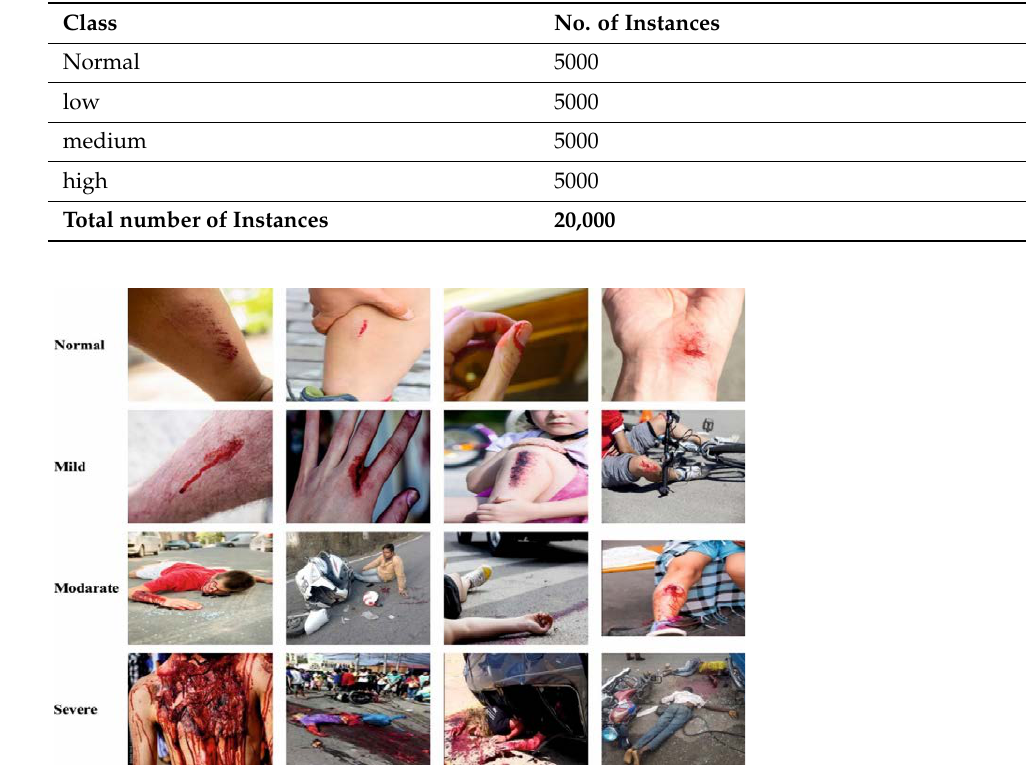
Figure 4. Result analysis of the PPIE-ODLASC system with distinct images. Table 3 and Figure 5 represent the PSNR results of the PPIE-ODLASC system with and without attacks. The outcome indicated that the PPIE-ODLASC algorithm has obtained effectual PSNR values under the presence of attack. For sample, in image1, the PPIE-ODLASC approach has obtained a PSNR of 57.68 dB and 56.73 dB for without and with attacks, respectively. Concurrently, on image3, the PPIE-ODLASC method has gained a PSNR of 56.26 dB and 55.14 dB for without and with attacks, correspondingly. Furthermore, in image6, the PPIE-ODLASC model has obtained a PSNR of 56.06 dB and 54.98 dB for without and with attacks, correspondingly. Table 3. PSNR analysis of the PPIE-ODLASC system under with and without attacks. Test Images